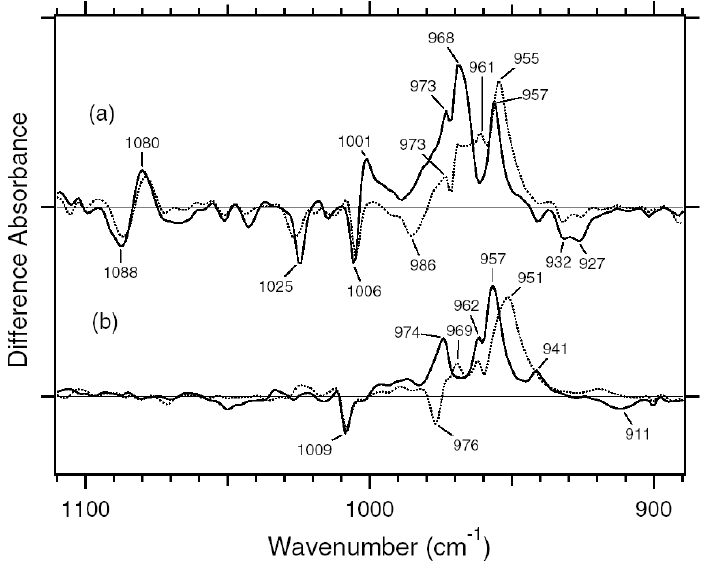
Figure 9. The ASR minus ASR (a) and the BR minus BR (b) spectra in K K the 1,110–890 cm -1 region, which correspond to hydrogen-out-of-plane (HOOP) vibrations of the retinal chromophore. The sample was hydrated with H O (solid lines) or D O 2 2 (dotted lines). One division of the y-axis corresponds to 0.002 absorbance units. This figure is reprinted with permission from Furutani et al. [20]. Copyright 2005 American Chemical